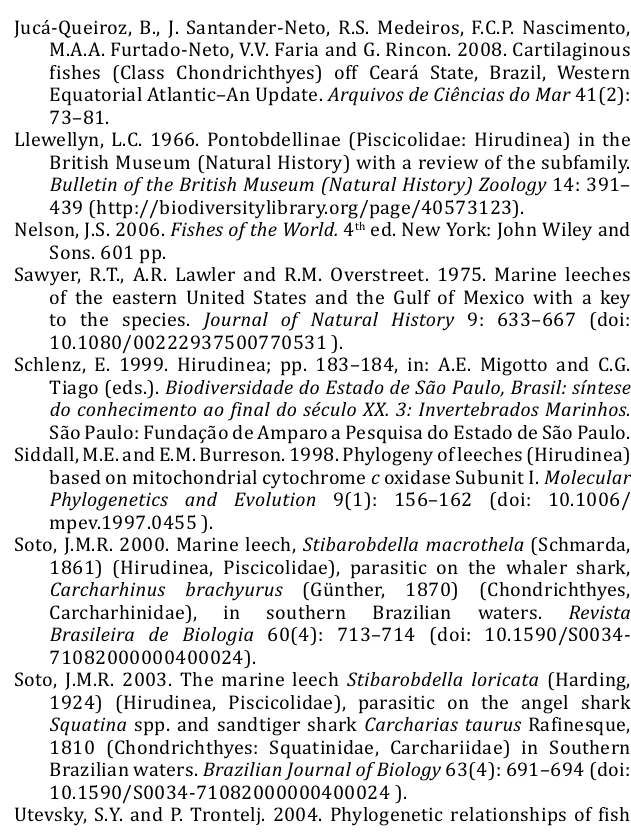
c Molecular oxidase Subunit I.